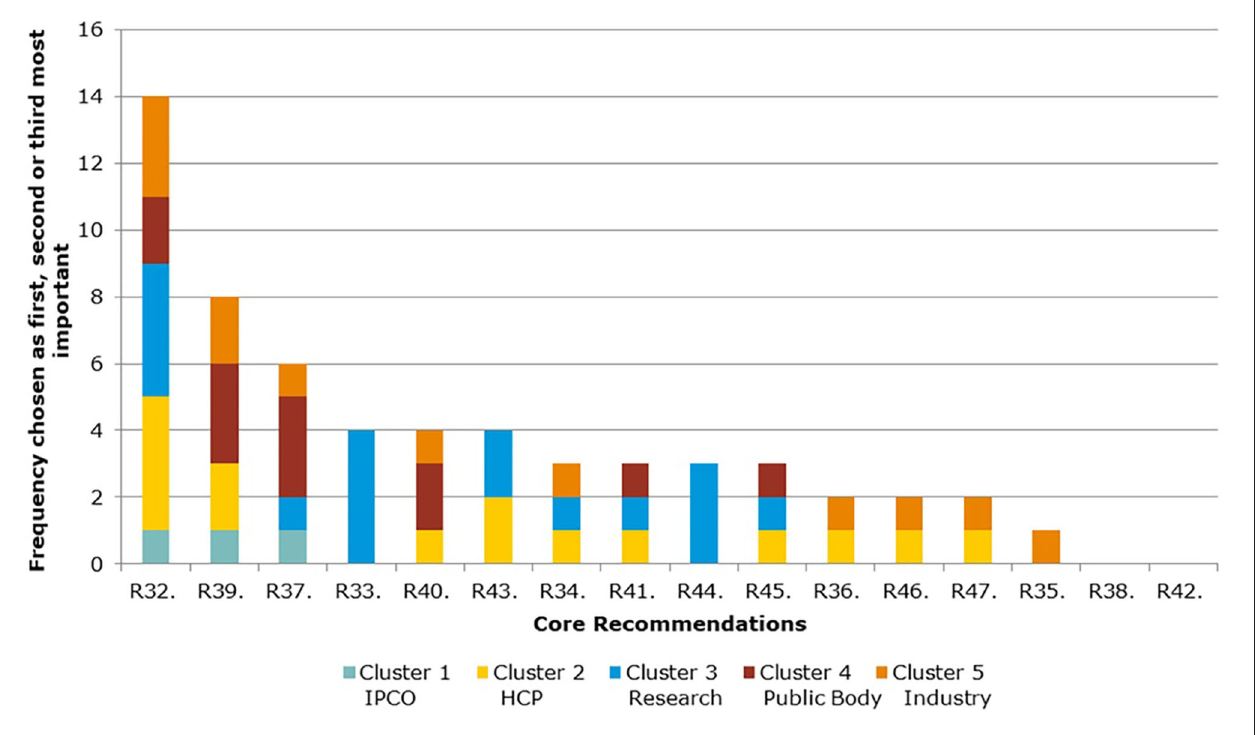
FIGURE 5 | Aggregate ranking of Core Recommendations (question 5,